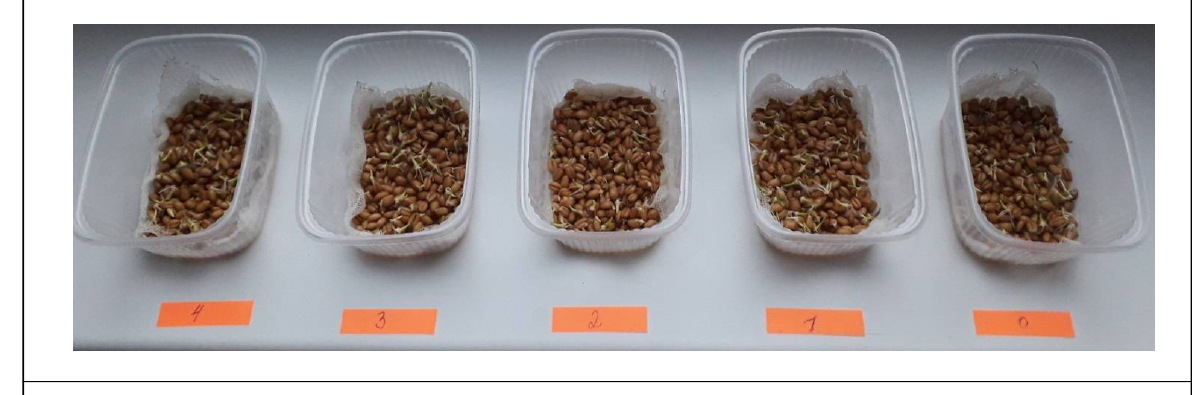
Figure 10: Tríticum durum in ordinary and “saturated” water (August 18,